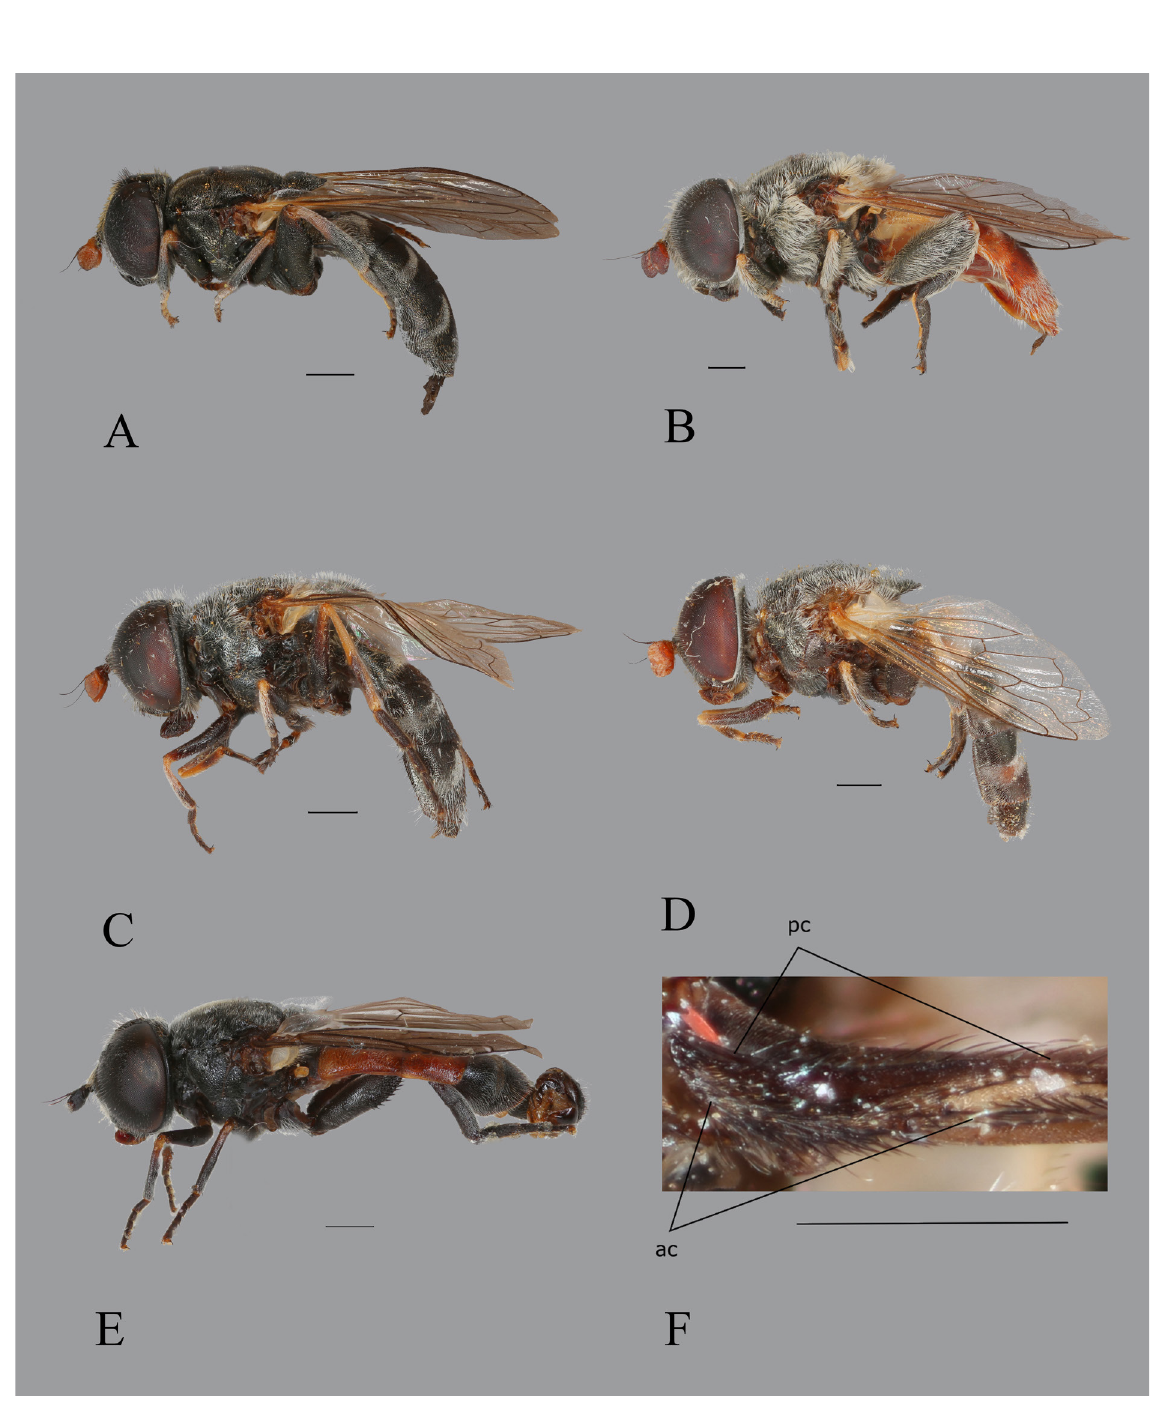
Fig. 8. A–E . Adult habitus, lateral view. F . Basicosta. A–D . Female. E–F . Male. A . Eumerus brevipilosus Gilasian & van Steenis sp. nov., paratype (HMIM). B . E. coeruleus (Becker, 1913), Ghoochan, Iran (HMIM). C . E. longitarsis Peck, 1979, Mian Jangal, Iran (JSA). D . E. persarum Stackelberg, 1961, Bazman, Iran (JSA). E . E. tricolor (Fabricius, 1798), Paleochori, Greece (JSA). F . E. tadzhikorum Stackelberg, 1949, Chekab Valley, Iran (JSA). Scale bars = 1.0 mm. Abbreviations: ac = anterodorsal costal setae; pc = posterodorsal costal